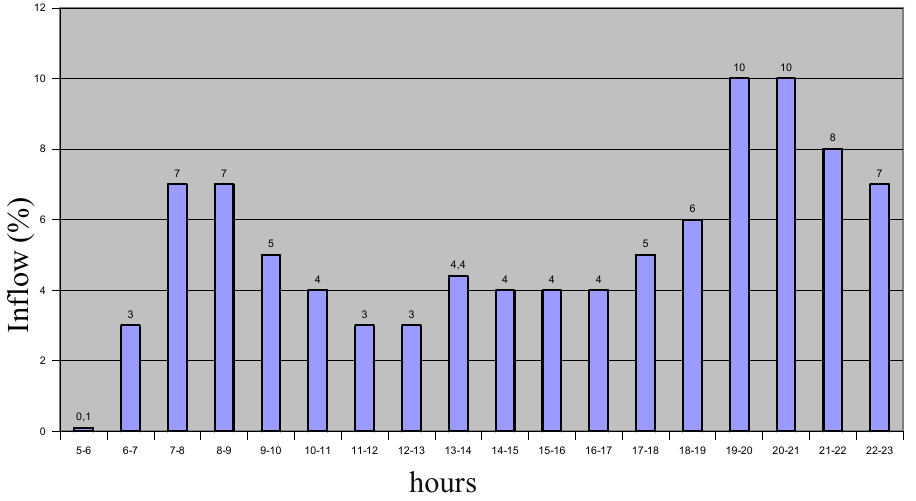
Figure A4. The dynamics of wastewater inflow to the pumping station by diurnal variation.